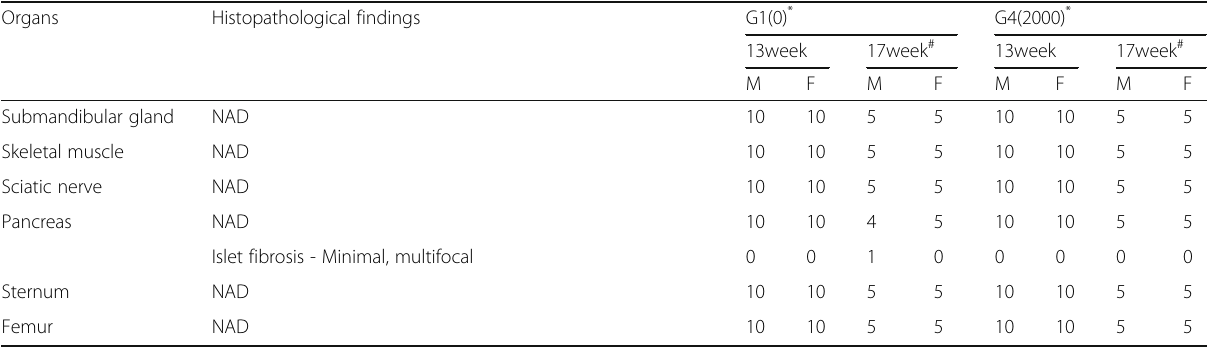
Table 7 Histopathological findings